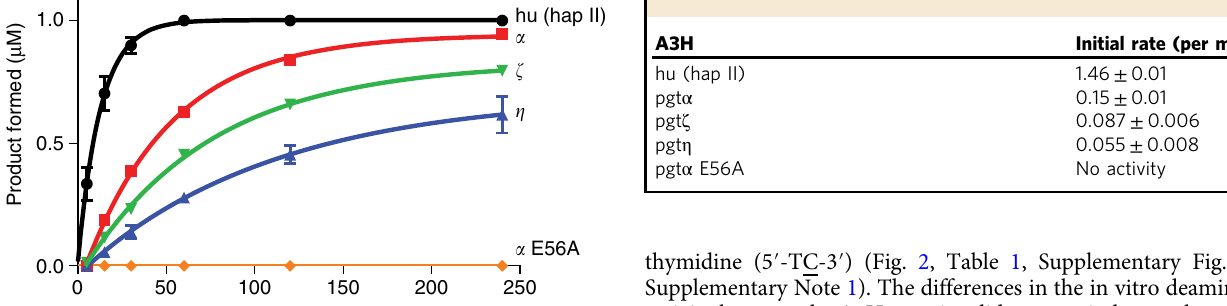
Table 1 Initial rates of A3H cytidine